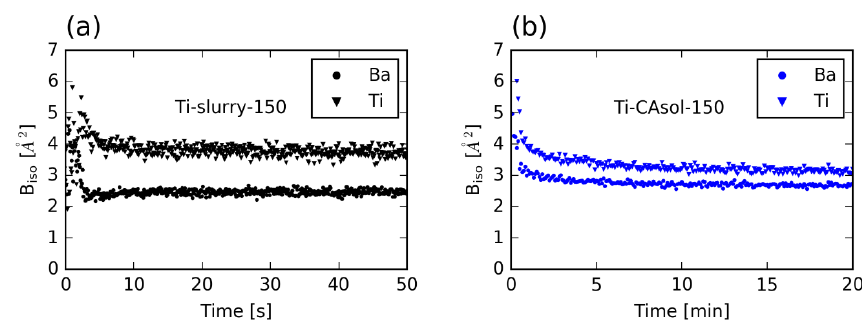
Figure 4. Isotropic atomic displacement parameters for Ba and Ti: ( a ) Ti-slurry-150 and ( b ) Ti-CAsol-150.